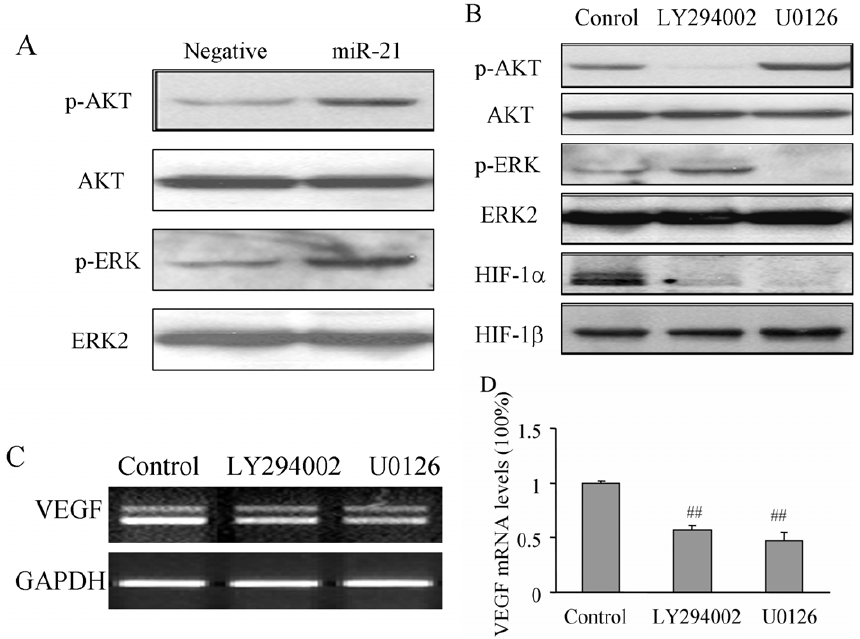
Figure 4. miR-21 induced the activation of AKT and ERK1/2, and the expression of HIF-1 a and VEGF. (A) DU145 cells were seeded into 60 mm dishes. When cells were 60% confluence, cells were transfected with pre-miRNA negative control or pre-miR-21 as described above. Total proteins were extracted 36 h after the transfection, and analyzed for the expression of phospho-AKT (p-AKT), total AKT, phospho-ERK1/2 (p-ERK), and ERK2 by immunoblotting. (B) DU145 cells were transfected with pre-miR-21 precursor as described above. After the transfection for 36 h, the cells were treated with solvent alone, 10 m M of LY294002, or 10 m M of U0126 for 6 h. The expression levels of p-AKT, total AKT, p-ERK, ERK2, HIF-1 a and HIF-1 b were analyzed by immunoblotting. (C-D) After the transfection of cells with pre-miR-21, the cells were cultured for 36 h, then treated with solvent alone, 10 m M of LY294002, or 10 m M of U0126 for 12 h. VEGF mRNA expression was analyzed by RT-PCR (C), and by real-time RT-PCR (D). ## , indicates the significant decrease when compared to that of the control ( p ,